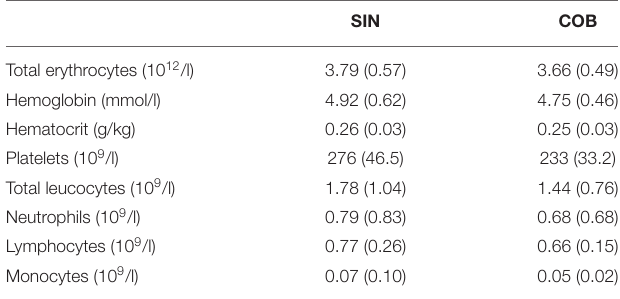
TABLE 1 | Blood hematology of three-day old single-housed or co-bedded